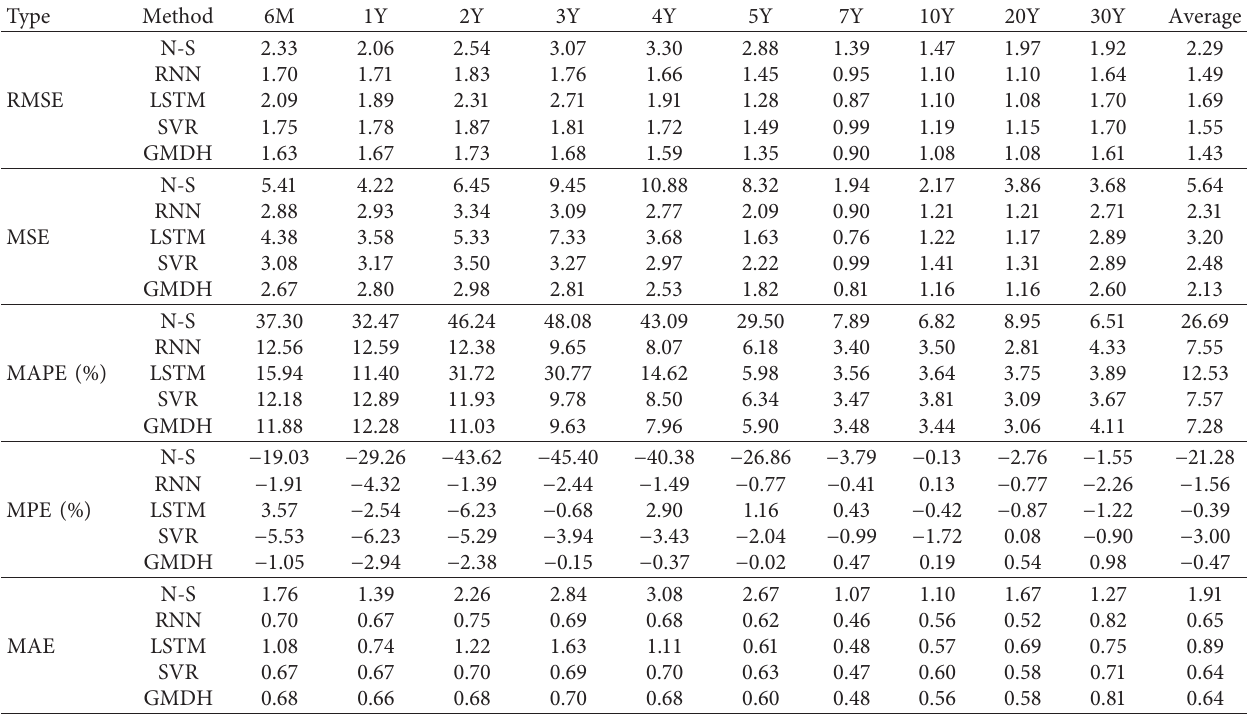
Table 6: Error statistics of each method for all maturities for test dataset 1 with the full period training set (case 1). Type